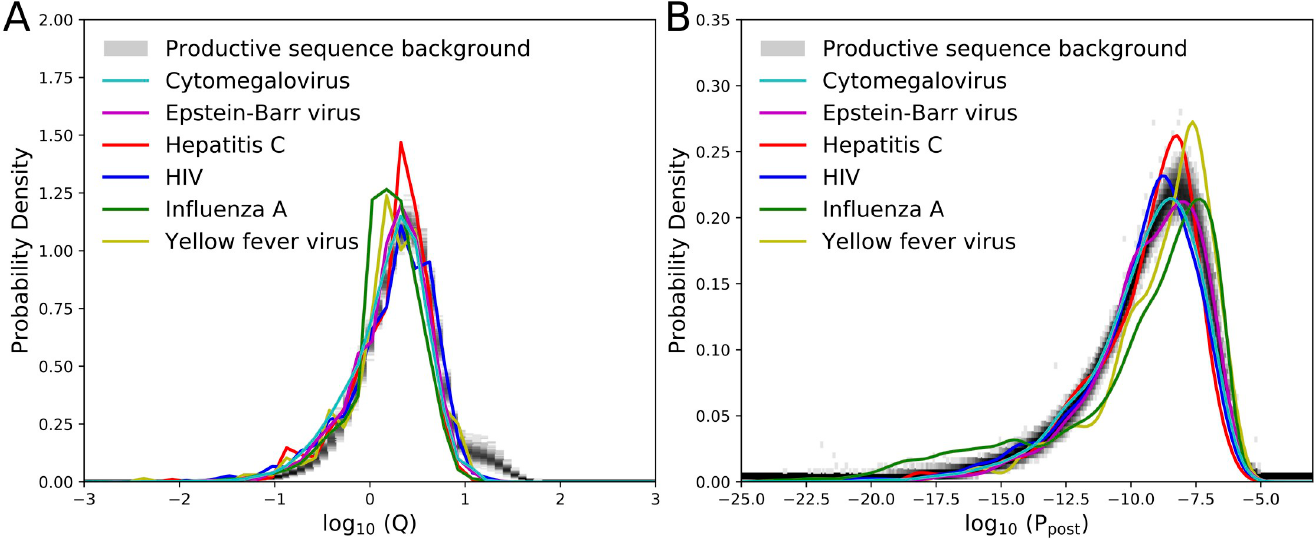
Fig 6. Distribution of TRB sequences from the VDJdb database specific to human viruses [19] compared to the productive sequences from the blood of 651 individuals. (A) log 10 ( Q univ ) distribution for each individual’s productive data sequences (gray heatmap) and for viral-specific TCRs from the VDJdb database. (B) ð P univ Þ distributions. The VDJdb log ð P univ Þ distributions are Gaussian-smoothed for clarity. Q univ and P univ log 10 10 post post randomly drawn from all